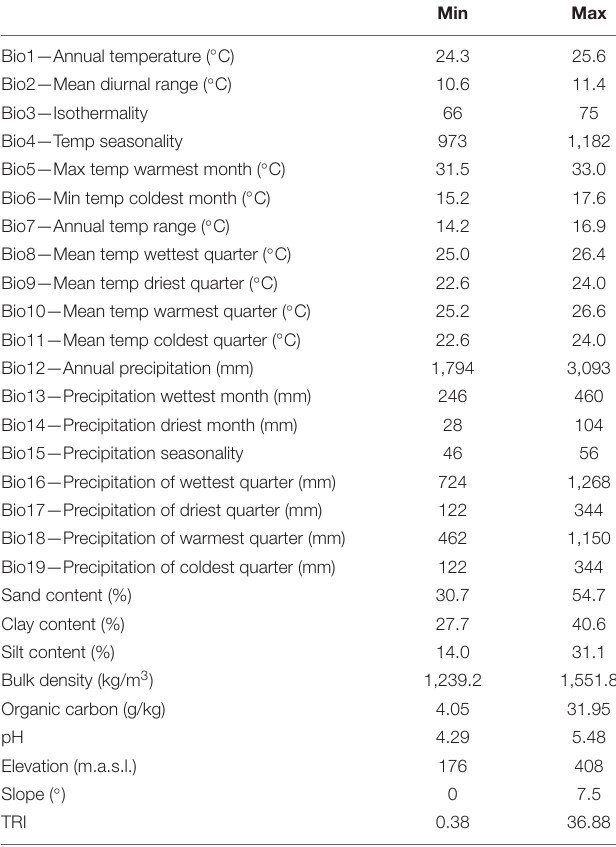
TABLE 1 | Ranges of considered environmental variables in the study